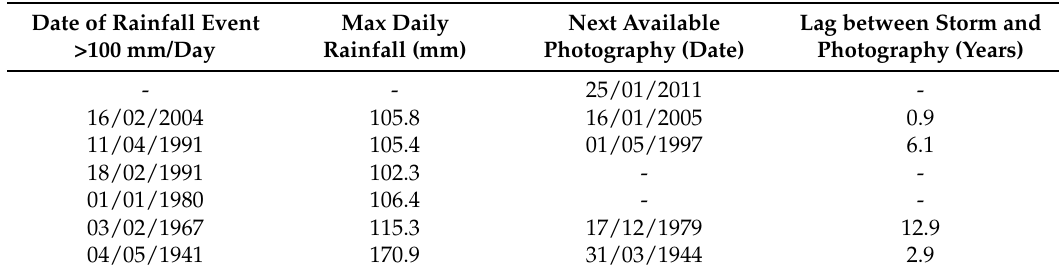
Table 3. Time lag between recorded rainfall events (Eastry Station—NZTM 1841003 E 5501939 N) and next available